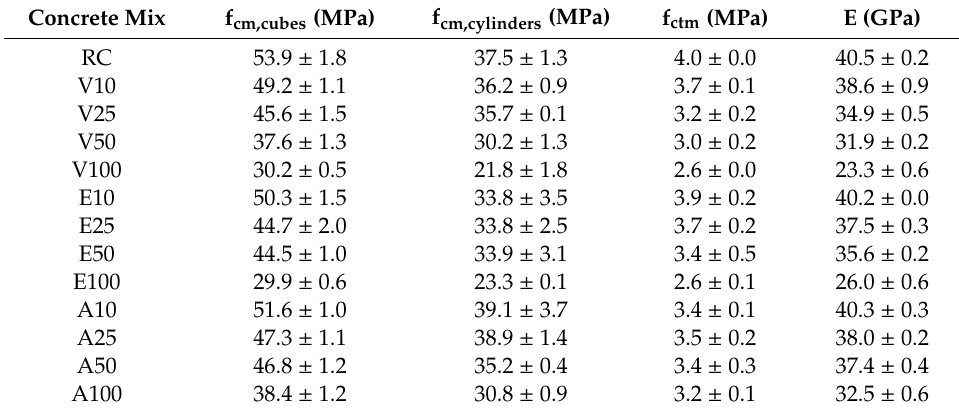
Figure 1. Details of ( a ) FRA from Europontal recycling plant, ( b ) shrinkage test and ( c ) cracking patterns of RC and A100 after the splitting tensile strength test. Table 1. Mechanical properties of the concrete mixes.